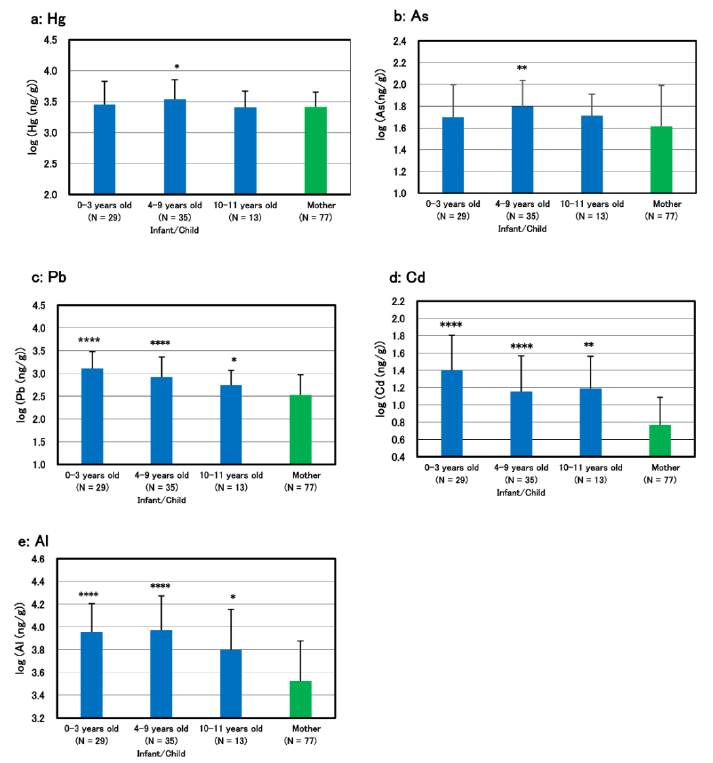
Figure 2. Geometric mean toxic metal concentrations in infants/children grouped by age and their mothers. ( a ) Mercury, ( b ) Arsenic, ( c ) Lead, ( d ) Cadmium, ( e ) Aluminum. Infants/children were grouped by age; 0–3, 4–9, and 10–11 year-old, and the geometric mean concentrations of toxic metals in each group were compared to those in their mothers. Statistically significant difference in the mean value in each age-group compared to their mother group is shown with asterisk marks: * p < 0.05, ** p < 0.01, **** p < 0.0001. Among essential minerals, the levels of some elements, such as chromium, molyb- denum, manganese, iron, and iodine in infants/children were significantly nearly two times higher than those in their mothers as well as for the above toxic metals. In contrast, the limited three elements of zinc, magnesium and calcium in infants/children were sig- nificantly lower than those in their mothers ( p < 0.0001) (Table 2), and 29, 9 and 8 indi- viduals (37.7, 11.7 and 10.4 %) in the infants/children group were estimated to be zinc-, magnesium- and calcium-deficient, respectively. There were a few or no individuals with deficiency in iron, copper, manganese, chromium, and molybdenum. Table 2. Mean essential mineral concentrations in scalp hairs of infant/child and their mother. Geometric Mean (ng/g)